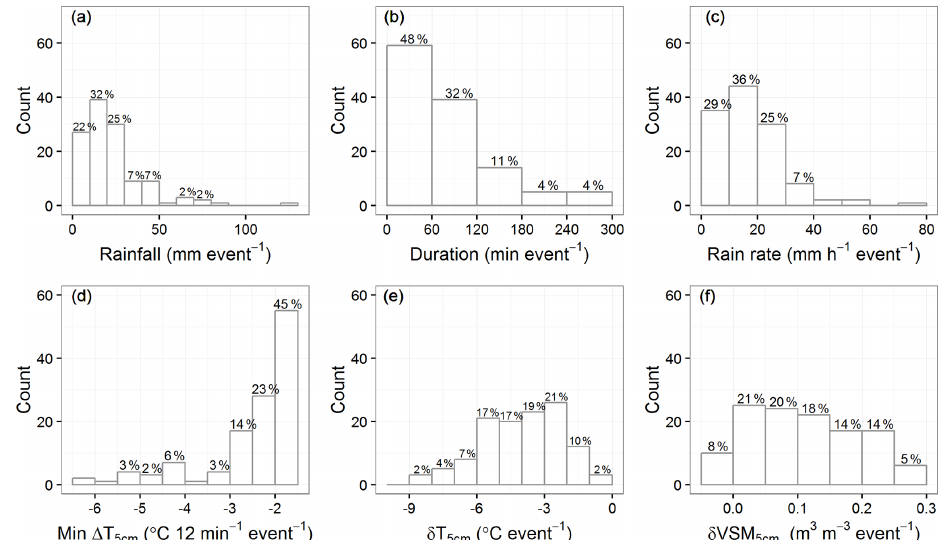
Figure 7. Statistical distribution of the 122 intense soil-cooling rains in terms of (Sect. 3.3) accumulated rainfall (a) , rain duration (b) , rain rate (c) , minimum (cid:49)T 5cm (d) , δT 5cm (e) , and δ VSM 5cm (f) , with bins of 10mm, 60min, 10mmh − 1 , 1 ◦ C, 1 ◦ C, and 0.05m 3 m − 3 ,